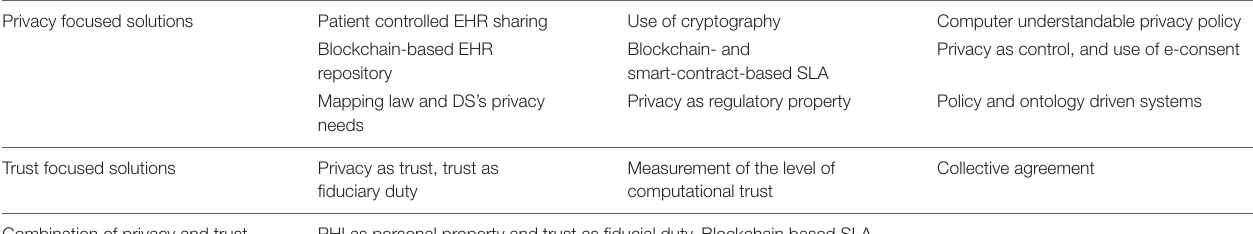
TABLE 1 | Examples of new privacy and trust solution for health